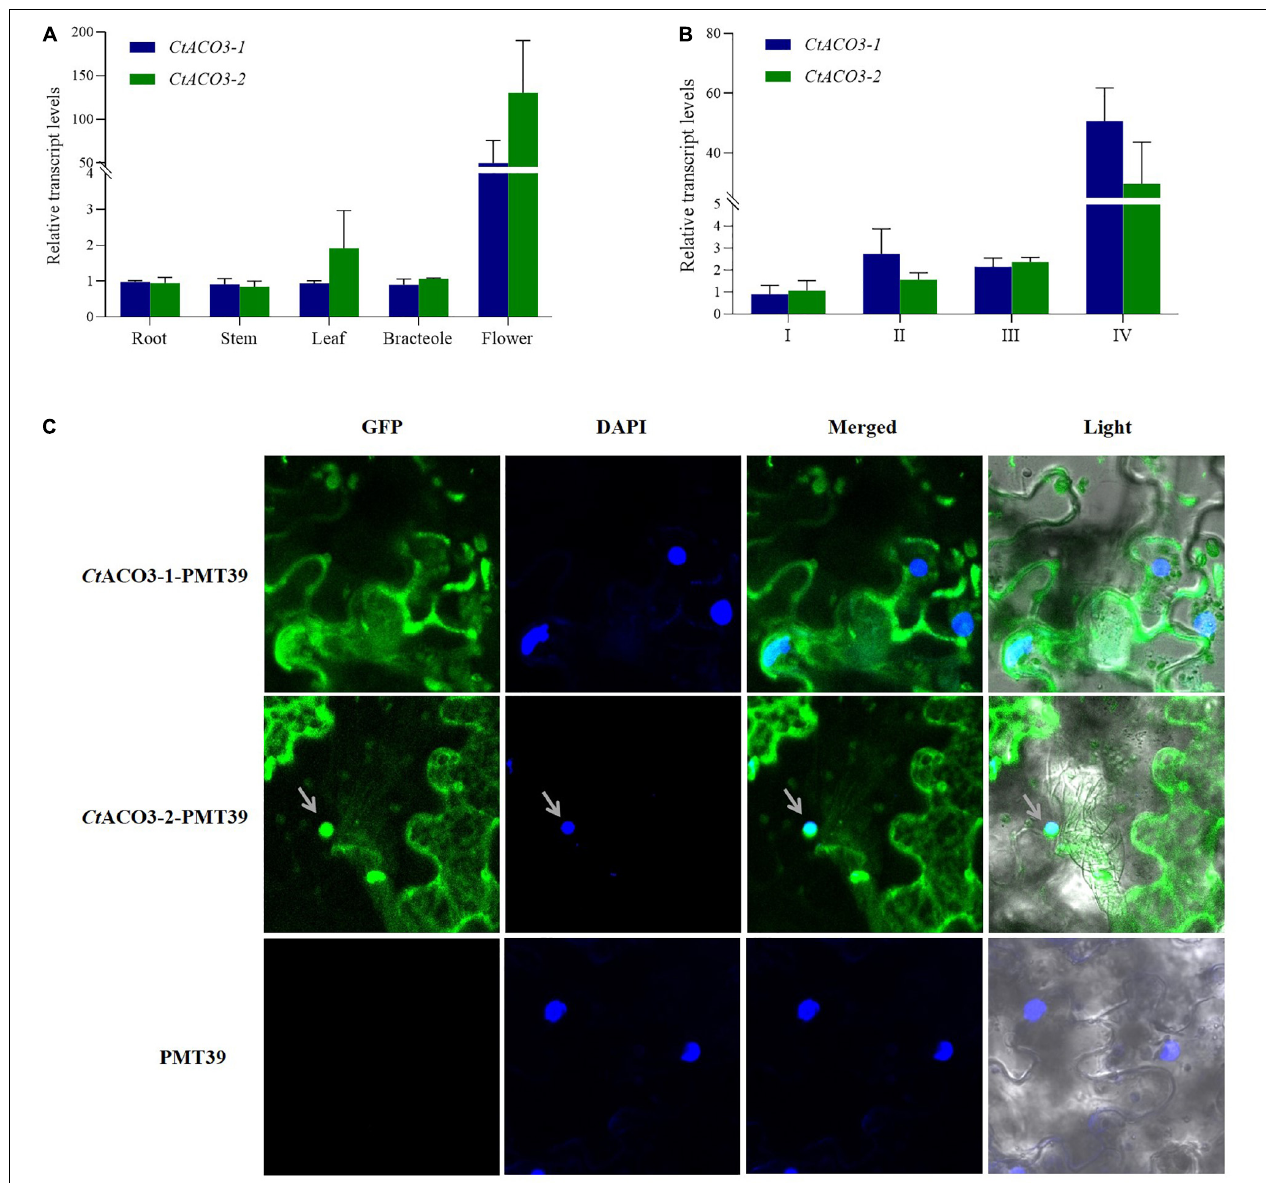
FIGURE 2 | The molecular characterization of CtACO3 splice variants . (A) Relative abundance of CtACO3-1 and CtACO3-2 in different tissues. (B) Relative abundance of CtACO3-1 and CtACO3-2 in different floret developmental stages. (C) Subcellular localization of the Ct ACO3-1/-2-PMT39 fusion protein in Nicotiana benthamiana leaves. Data were expressed as means ± SD ( n =